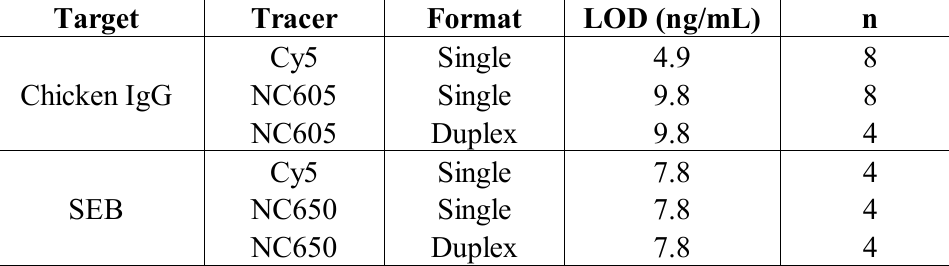
Table 1. Limits of detection (LOD) determined from the dose response